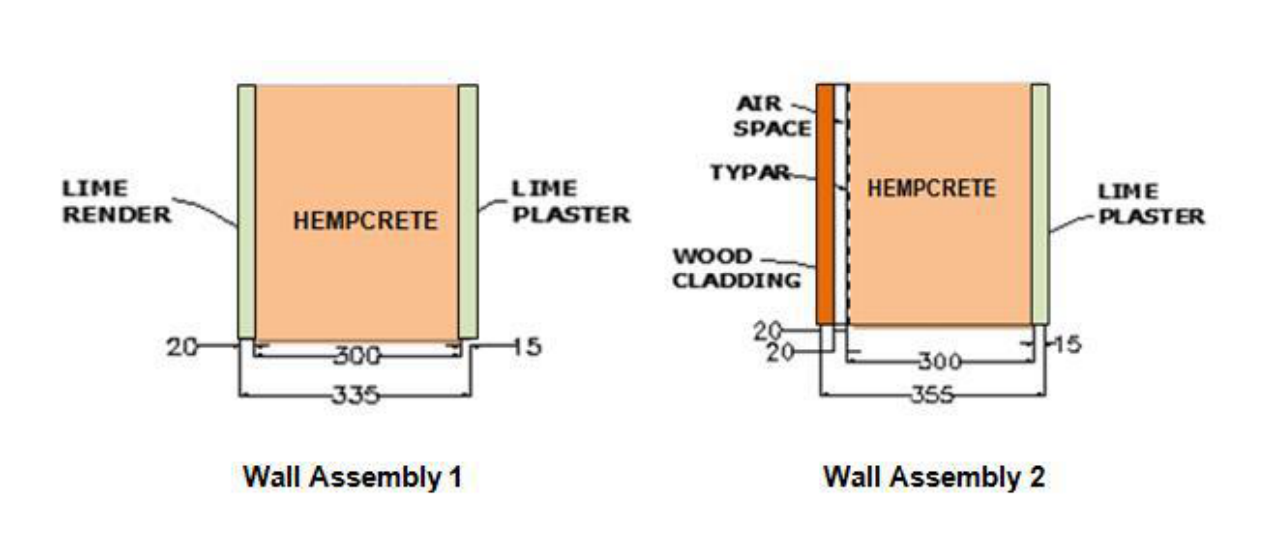
Figure 2. Proposed wall assemblies for the